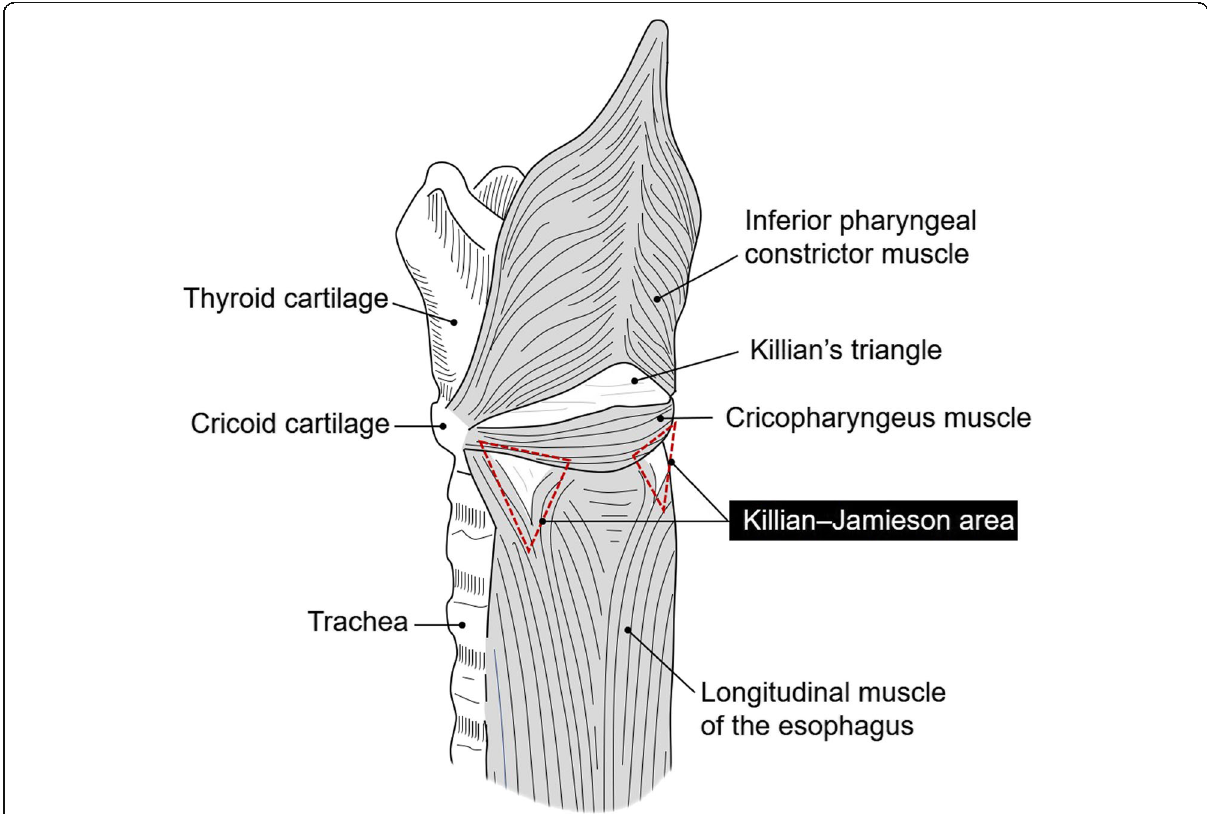
Fig. 3 Illustration of the pharyngoesophageal area. ZD arises through a muscular gap in the posterior wall below the inferior pharyngeal constrictor muscle and above the cricopharyngeus muscle, known as Killian ’ s triangle. KJD arises through a muscular gap in the anterolateral wall of the cervical esophagus just below the cricopharyngeus muscle and superolateral to the longitudinal muscle of the esophagus, known as the Killian – Jamieson